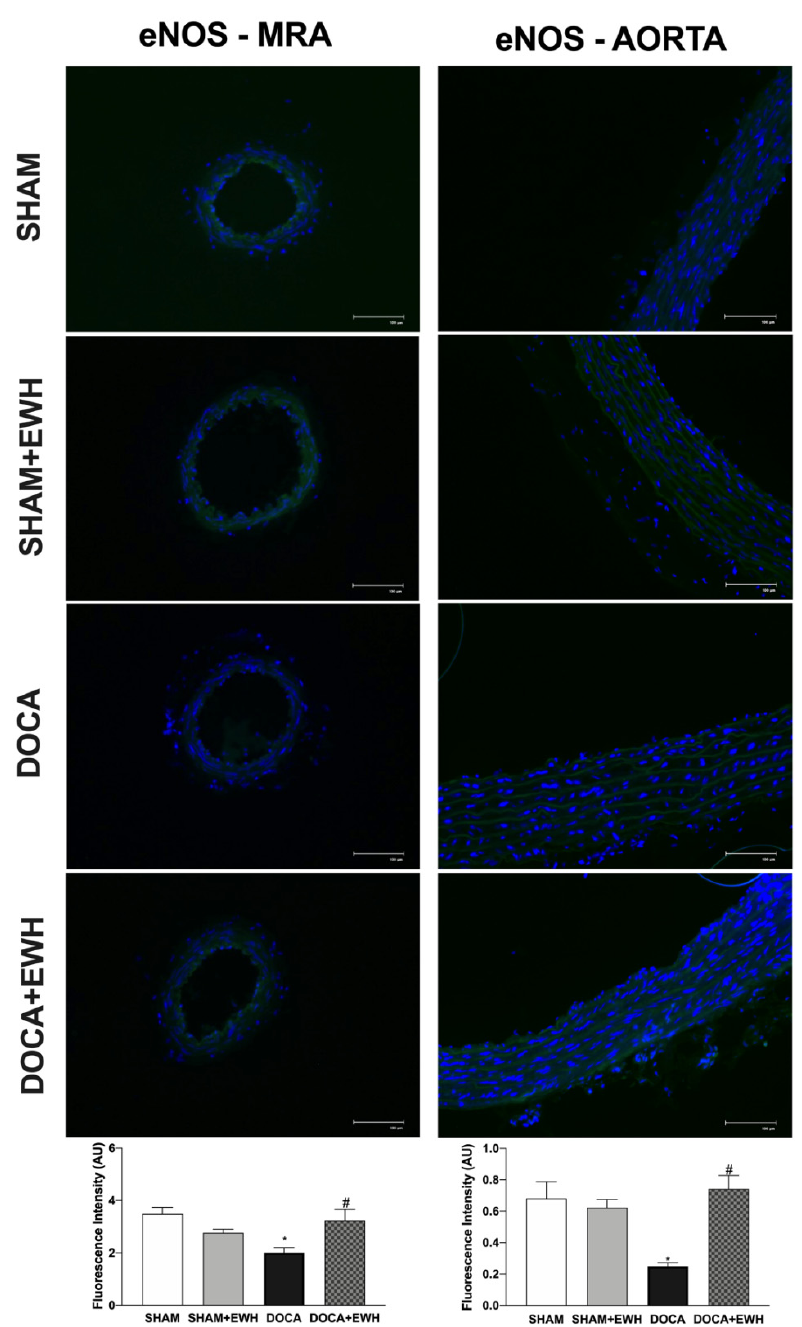
Figure 11. The role of EWH on endothelial NO synthase (eNOS) expression in MRA and aorta section of DOCA-salt rats. Representative photomicrographs ( × 40 magnification) and histogram of eNOS immunofluorescence of MRA (left panels) and aortic (right panels) sections of SHAM, SHAM+EWH, DOCA, and DOCA+EWH arteries. Data are expressed as mean ± SEM, n = 8. The images correspond to the merge of the marking of the colors by the DAPI in blue and the eNOS in green. Two-way ANOVA followed by Bonferroni post-test: p < 0.05 * vs. SHAM; # vs. DOCA.